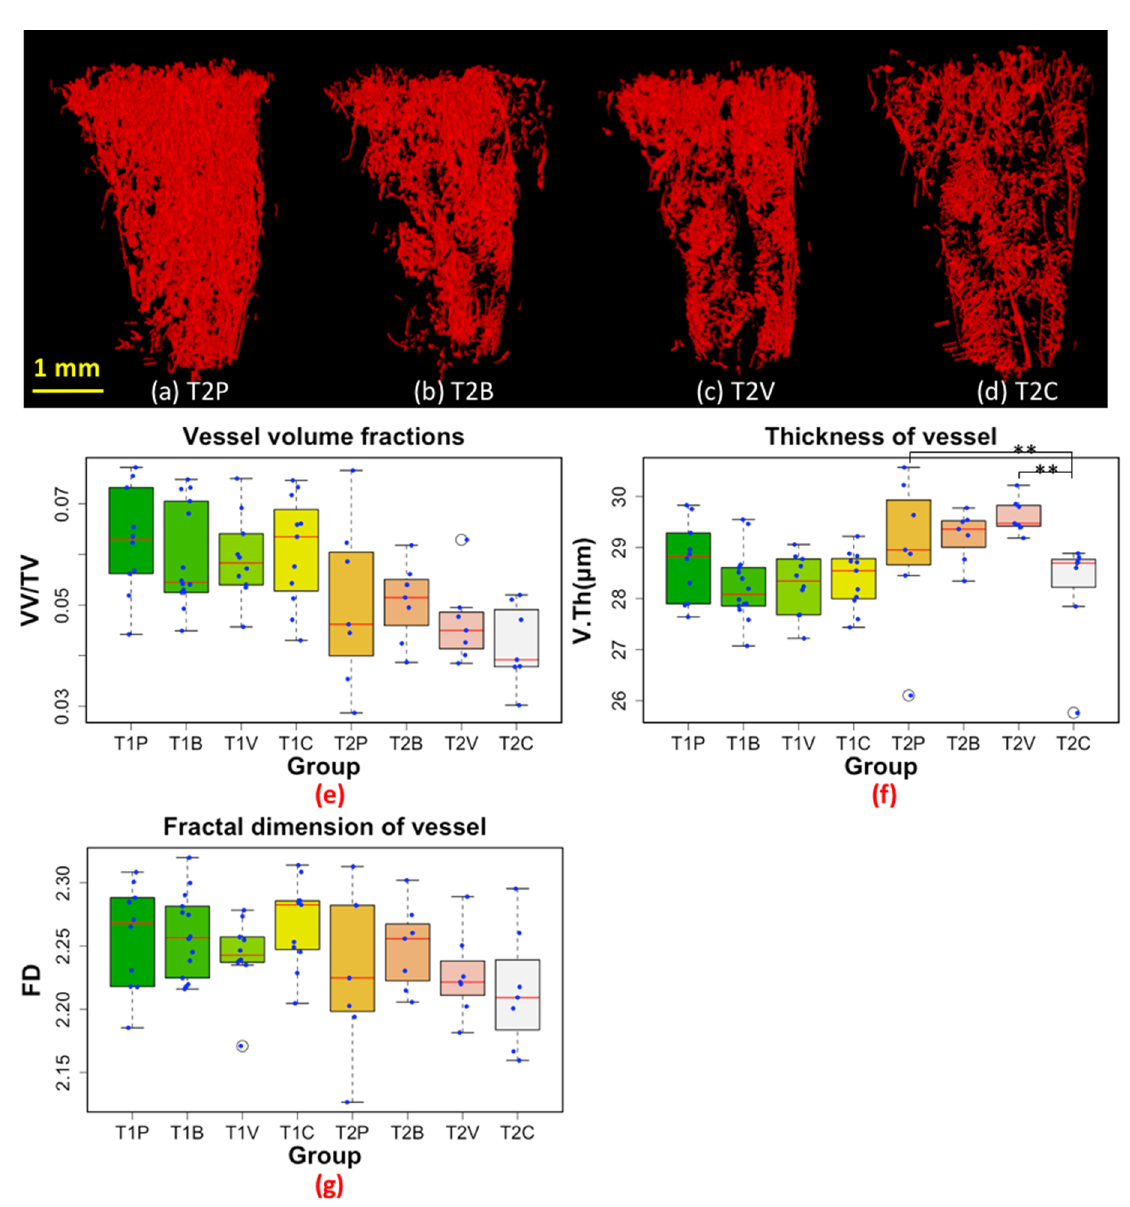
Figure 5. ( a – d ) 3D rendering of the segmented blood vessels at T2. ( e ) Boxplot of vessel volume fractions (VV/TV). ( f ) Boxplot of average vessel thickness (V.Th). ( g ) Boxplot of fractal dimension (FD) of blood vessels. Outliers are indicated with circles. The red line in each box represents the median value for the data set. Asterisk ** denotes statistically significant difference, at p = 0.05 level. All data points (blue) were plotted along with the box plots. T1 and T2 denote time points at day 8 and 22 post tumor cell inoculation, respectively (P: Placebo, B: Bevacizumab, V: Vatalanib, C: Combination of Bevacizumab and Vatalanib).